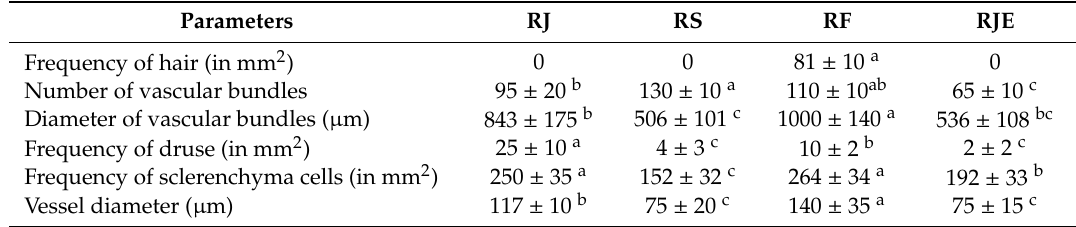
Figure 4. Photomicroscopic data of the stem from the four Reynoutria plants: ( a ) surface section of the stem; ( b ) and ( c ) transverse sections of the stem. The black bars mean 100 µ m. ca : druse; sc : sclerenchyma cell; vb : vascular bundle; v : vessel. Table 4. Anatomical characteristics of the stem from four Reynoutria plants.